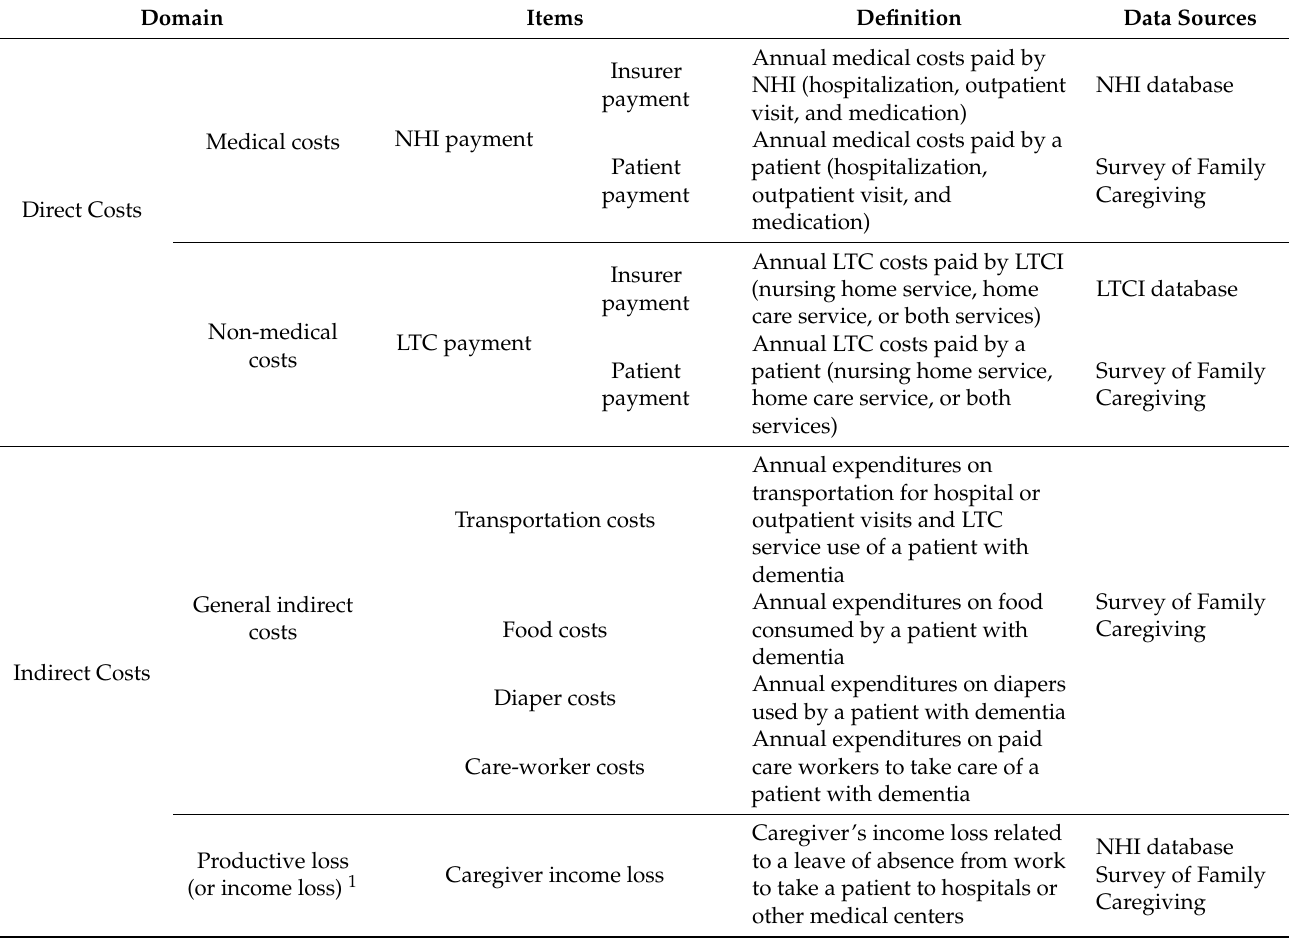
Table 1. Measure: Key items, Definitions, and Data